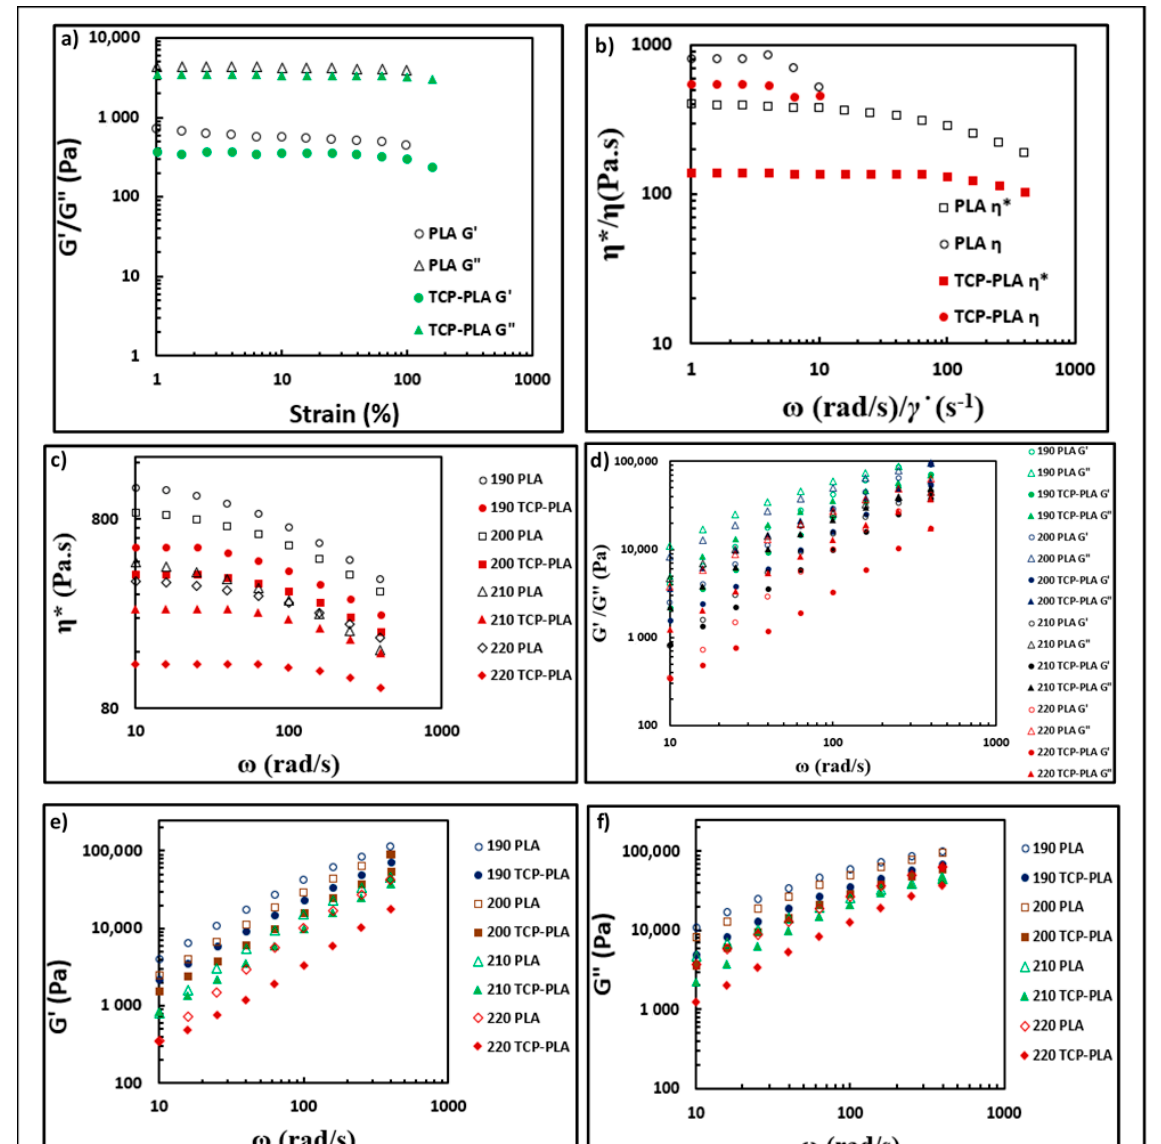
Figure 10. Rheological properties. ( a ) Dynamic strain sweep test (elastic modulus (G ʹ )/viscous modulus (G ʺ ) vs. strain%). ( b ) Investigating Cox–Merz rule (complex viscosity ( η *)/shear viscosity ( η ) vs. frequency ( ω )/shear rate ( γ )). ( c – f ) Complex viscosity, elastic modulus, and viscous modulus obtained from the dynamic frequency sweep test.